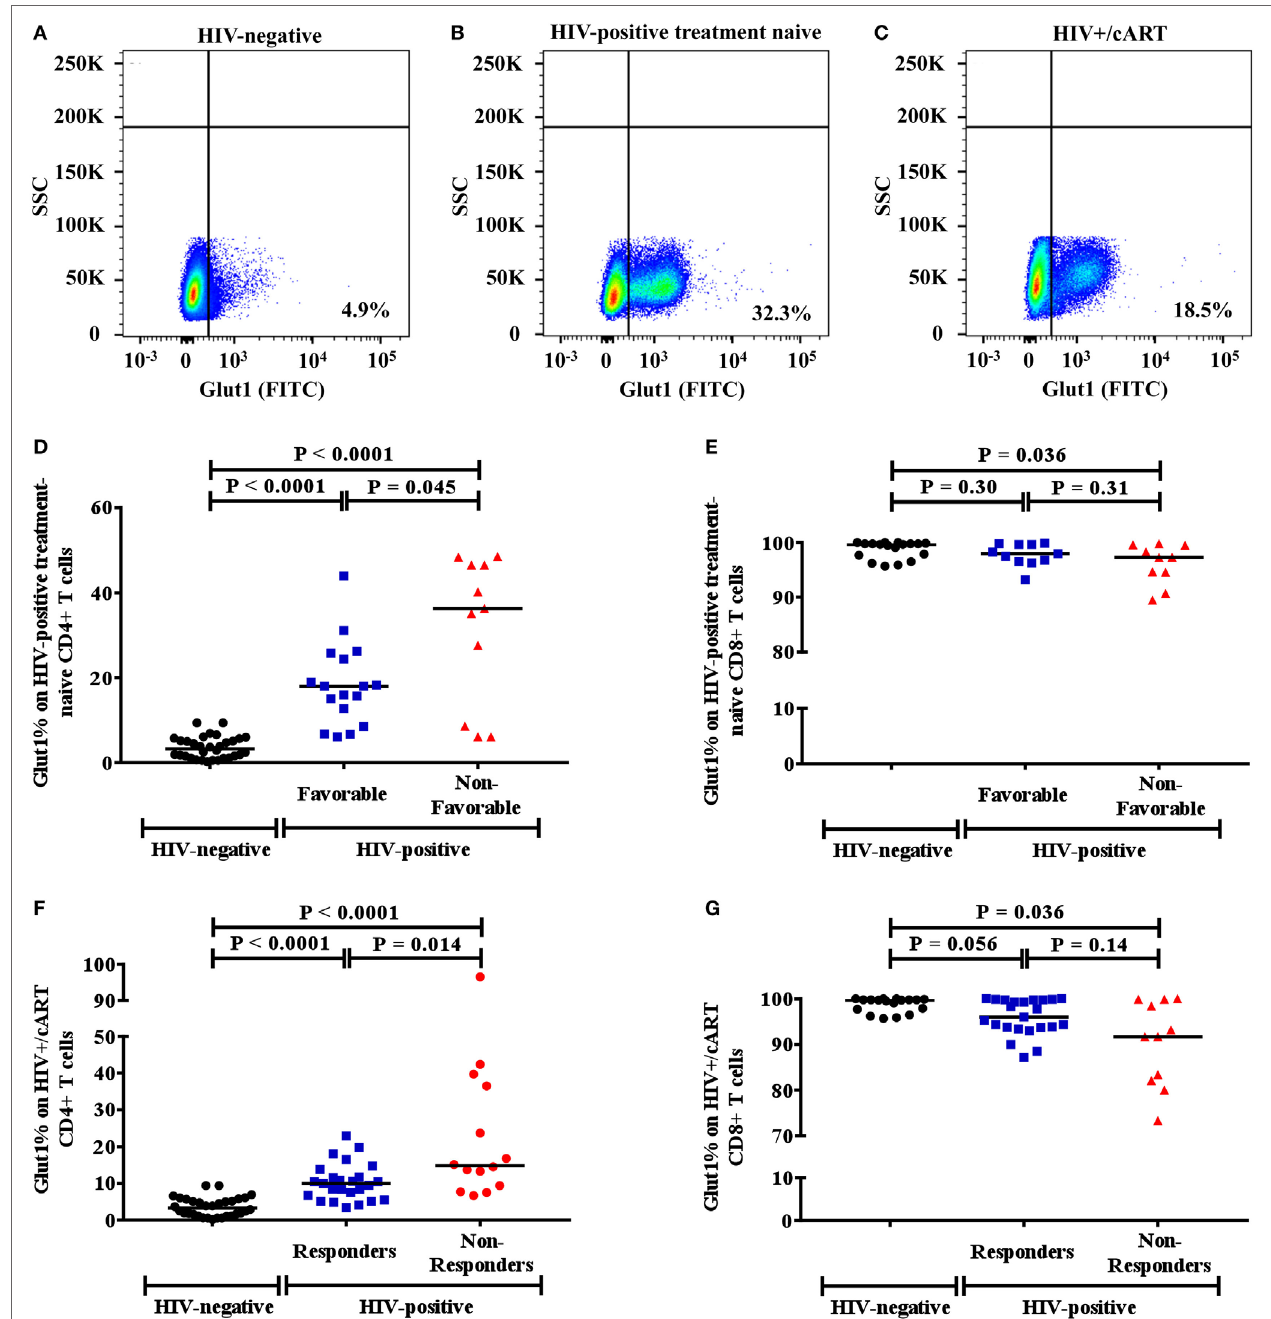
FigUre 1 | Gaiting strategy and analysis of CD4 + Glut1 + T cell percentage in HIV-negative and HIV-positive populations. (a–c) Percentage of Glut1 expressing CD3 + CD4 + T cells within the lymphocyte population were defined using side scatter (SSC) and the Glut1 fluorophore (FITC); (D,e) comparison between HIV-negative controls and HIV-positive treatment-naïve groups with favorable and non-favorable disease progression; (F,g) comparison between HIV-negative controls and HIV + /cART responder and non-responder groups. Horizontal black lines refer to median CD4 + Glut1 + or CD8 + Glut1 + T cell percentages of each group. cART, combination antiretroviral